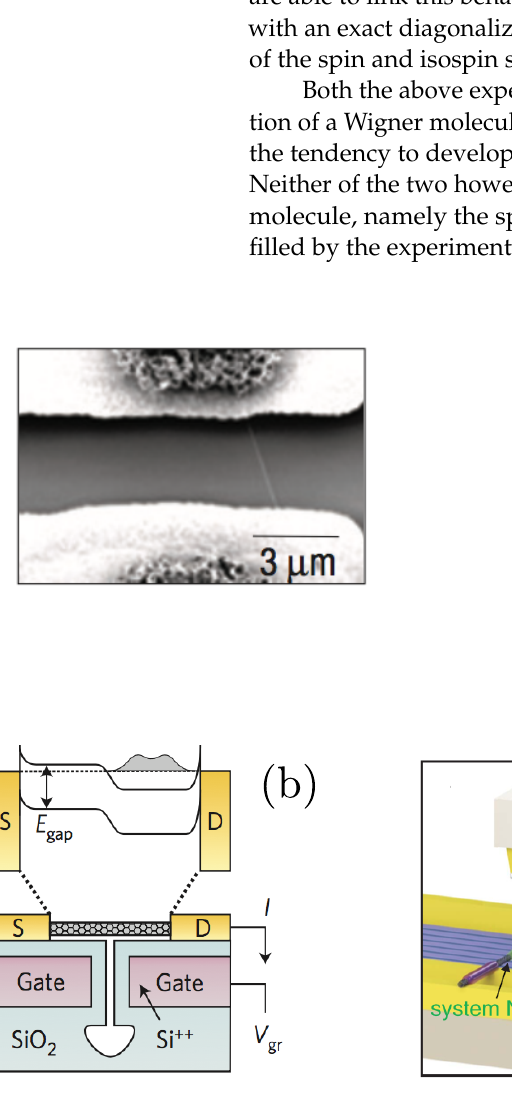
Figure 4. The experimental setup for the three key experiments assessing the properties of Wigner molecules in one- dimensional system discussed in this review: ( a ) a suspended semiconducting nanotube in the hole regime [116]; ( b ) a suspended tunable carbon nanotube [119]; ( c ) a complex setup, with a nanotube split into two parts which respectively act as the region where the Wigner molecule is formed and as a charge detector with an additional transverse suspended nanotube capacitively coupled to the Wigner molecule